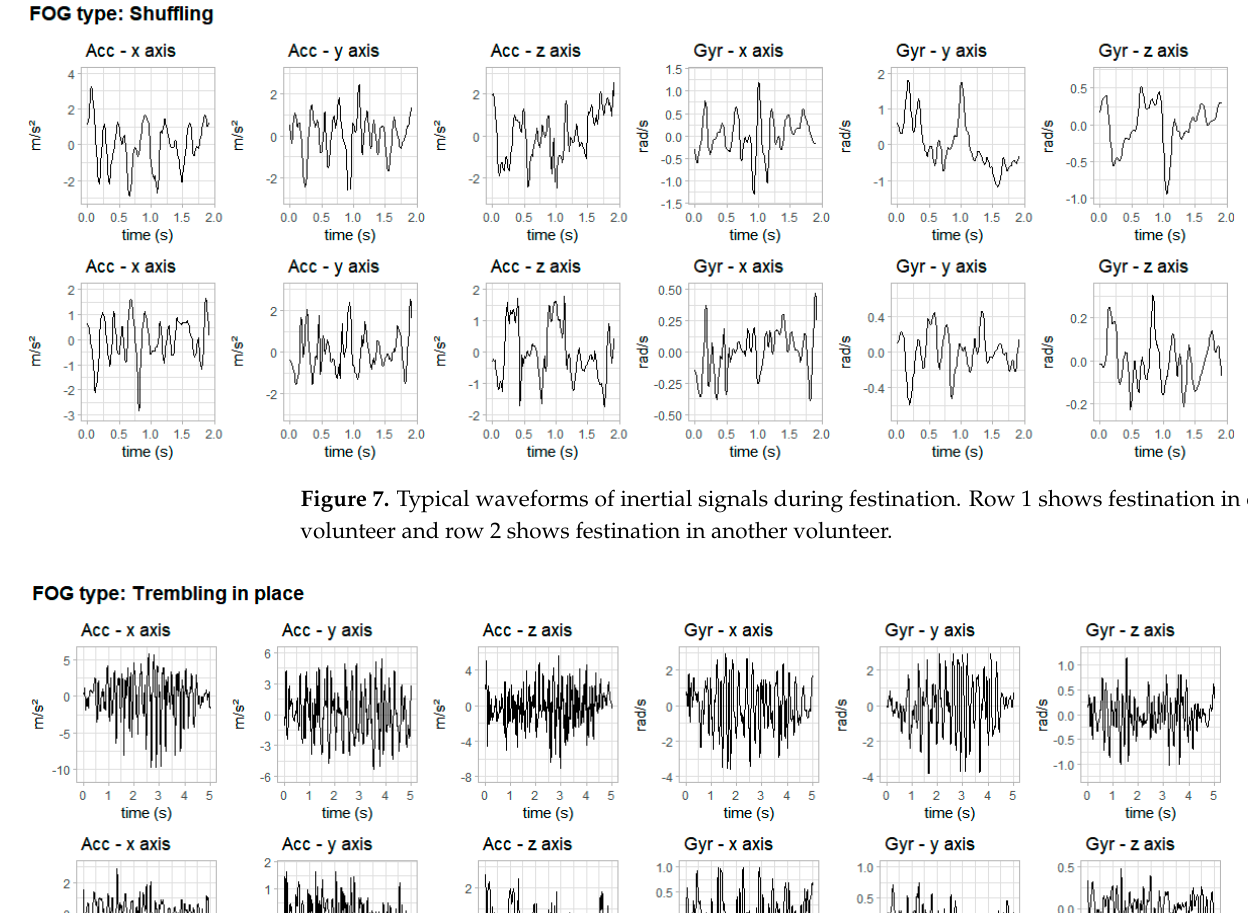
Figure 6. Typical waveforms of inertial signals during akinesia. Row 1 shows akinesia in one vol- unteer and row 2 shows akinesia in another volunteer.